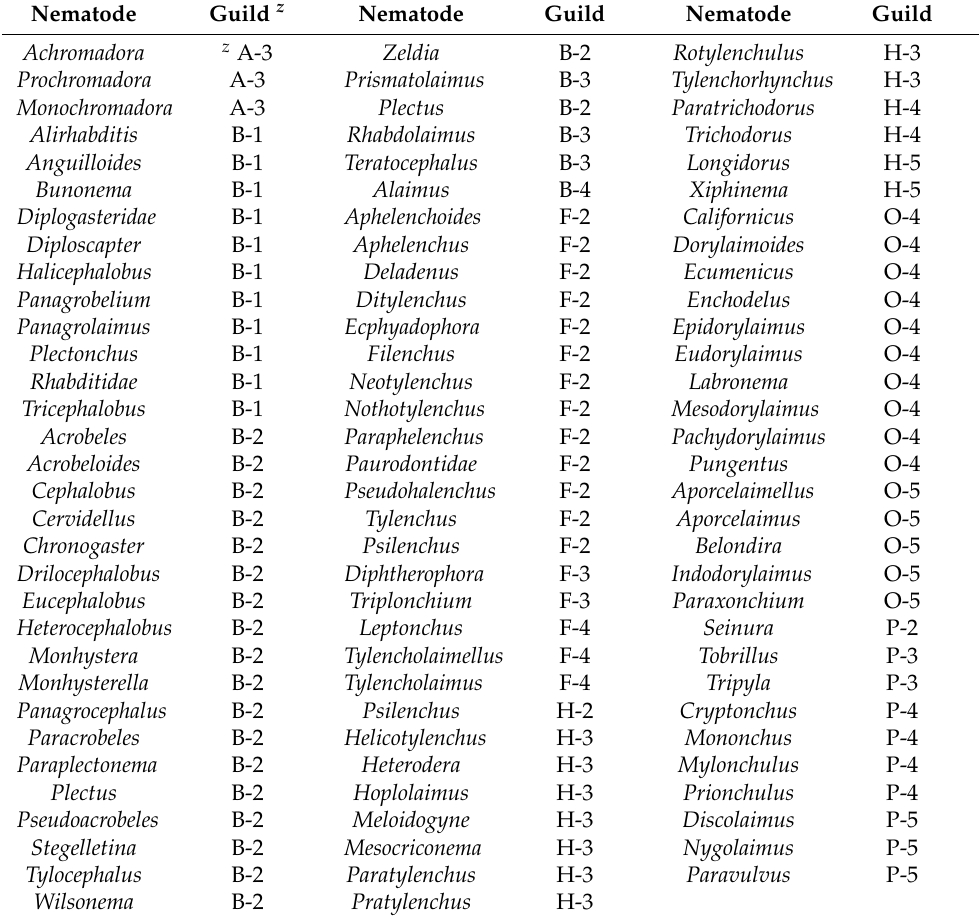
Table 1. Nematode genera found in the experimental site throughout